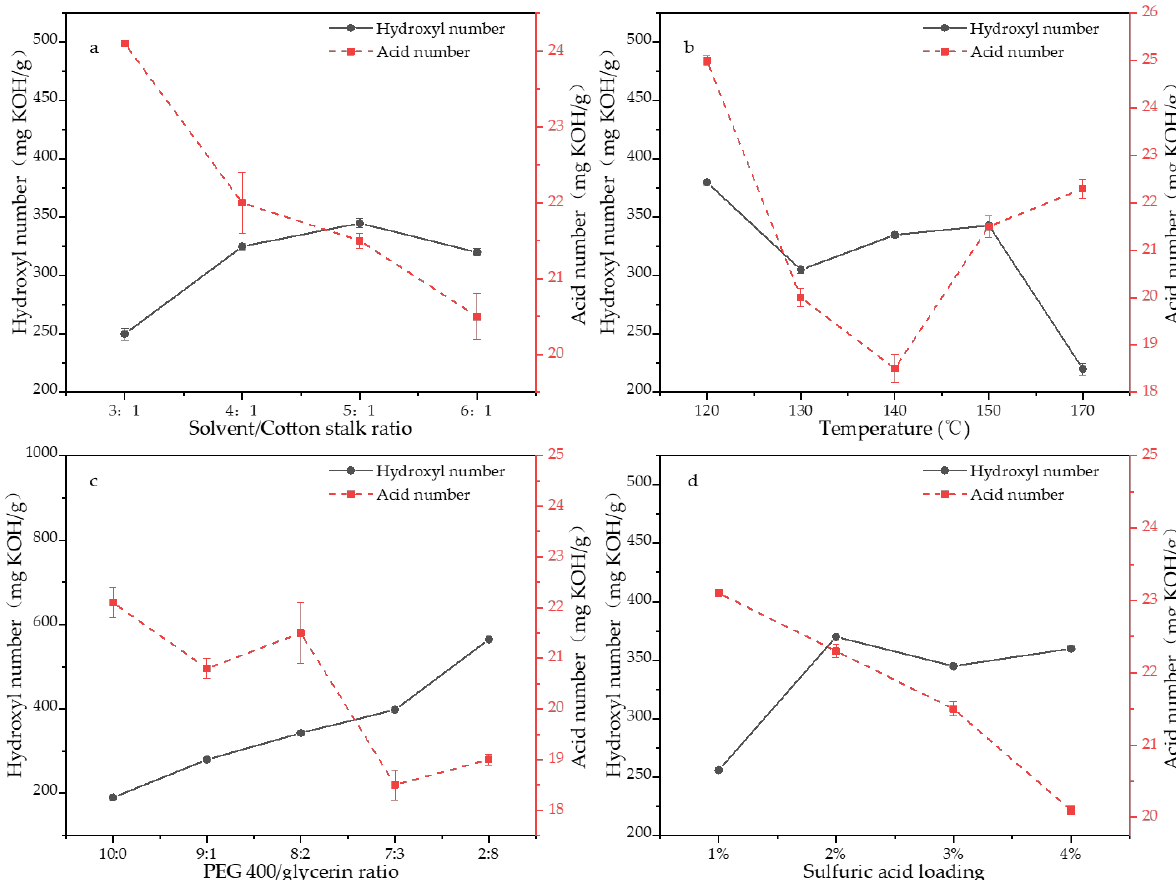
Figure 1. Effects of liquefaction conditions on the acidity and hydroxyl number of biopolyols: ( a ) Solvent/Cotton stalk ratio, ( b ) temperature, ( c ) PEG 400/glycerin ratio, and ( d ) catalyst (sulfuric acid) content. PEG 400/glycol mass ratio 8/2, reaction time 90 min, liquefaction solvent to cotton stalk ration 5/1, and the amount of concentrated sulfuric acid of the catalyst is 3% of the mass of the liquefaction agent. The effect of liquefaction temperature on the liquefaction effect and the hydroxyl value of the liquefied product is investigated. The results are shown in Figure 1b. The residue content of liquefied cotton stalk decreased from 30.0 to 13.5%. The greater the liquefaction reaction temperature, the higher the liquefaction efficiency.